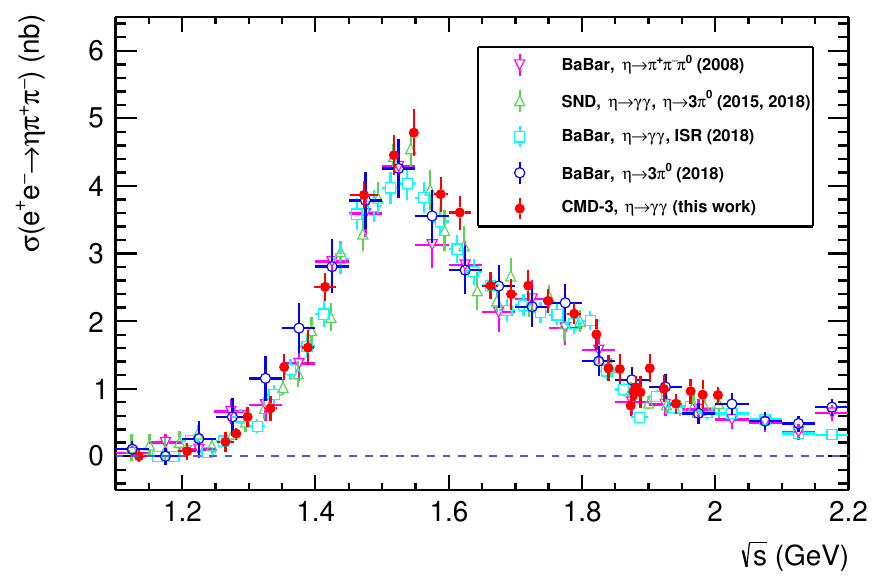
Figure 7 . Born cross section for e + e (cid:0) ! (cid:17)(cid:25) + (cid:25) (cid:0) measured at the CMD-3, SND and BaBar. The vertical errors for the Born cross section measured at the CMD-3 correspond to square roots of the error matrix diagonal elements. The close points of the cross section measured with the CMD-3 detector are combined together.